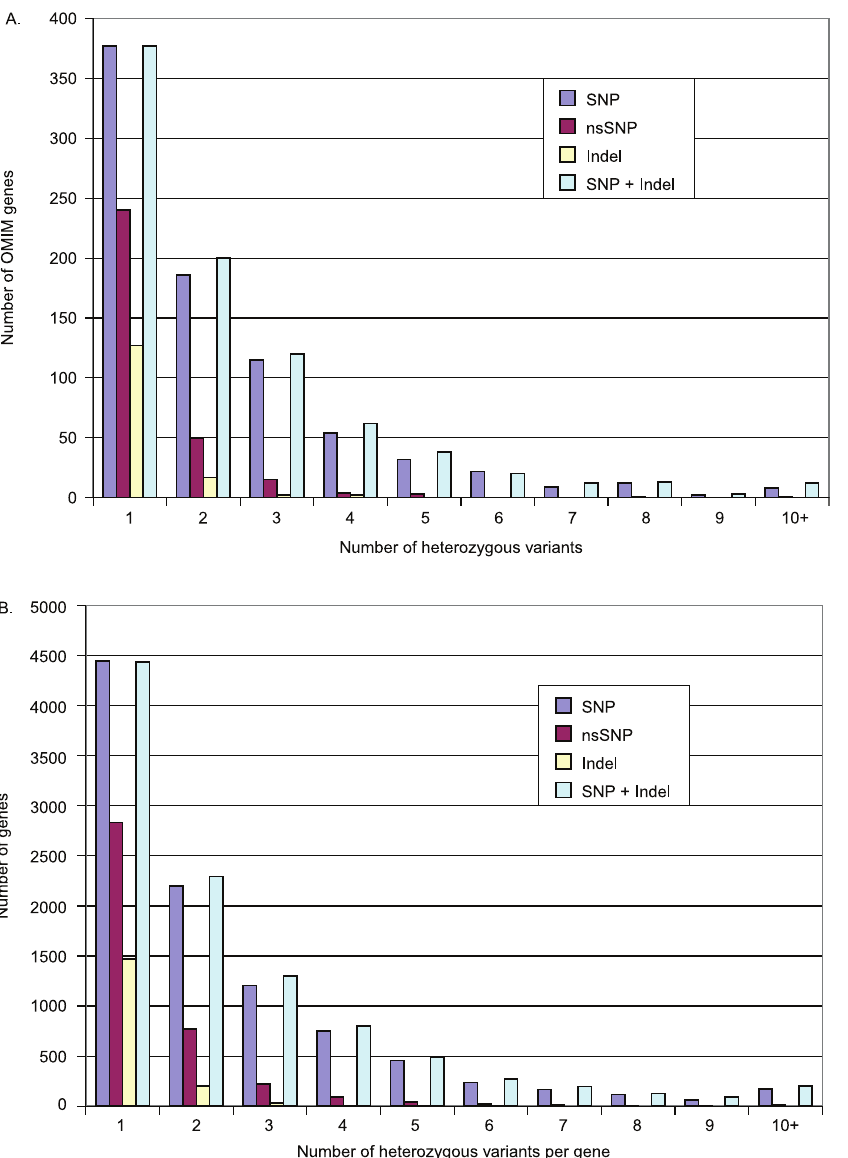
Figure 14. Distribution of HuRef Variants in OMIM and Ensembl Genes (A) The distribution of the OMIM genes in Ensembl version 41 protein coding genes that contain one or more SNP or indel in their coding and/or UTR regions. (B) A similar distribution for the variants found in coding and/or UTR regions for all Ensembl version 41